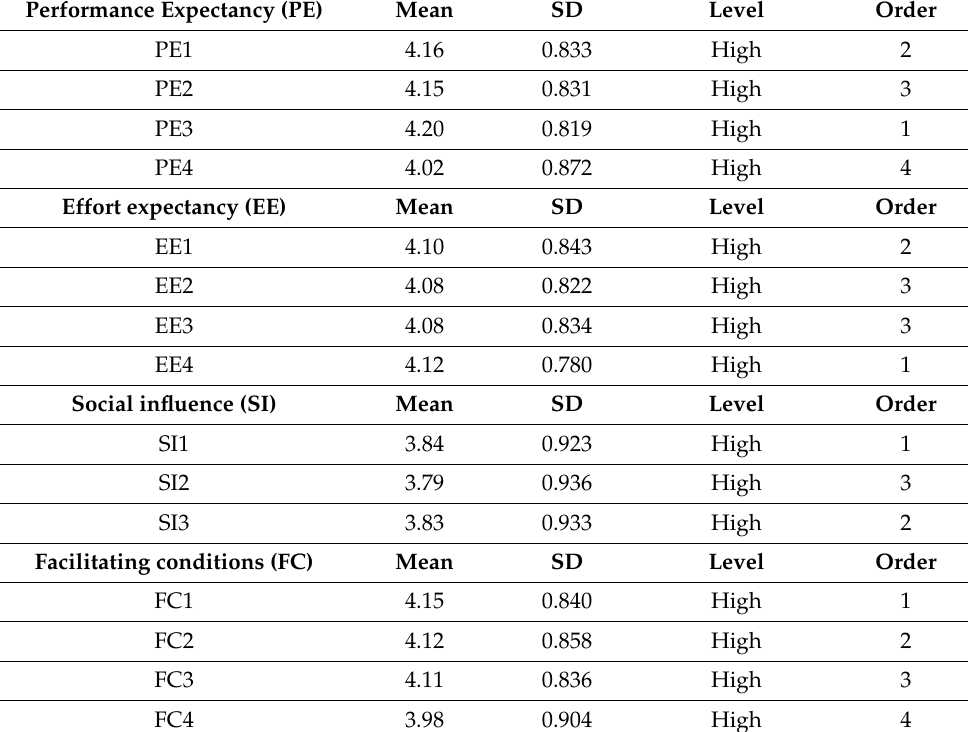
Table 4. Mean and standard deviation of the study’s variables. Performance Expectancy